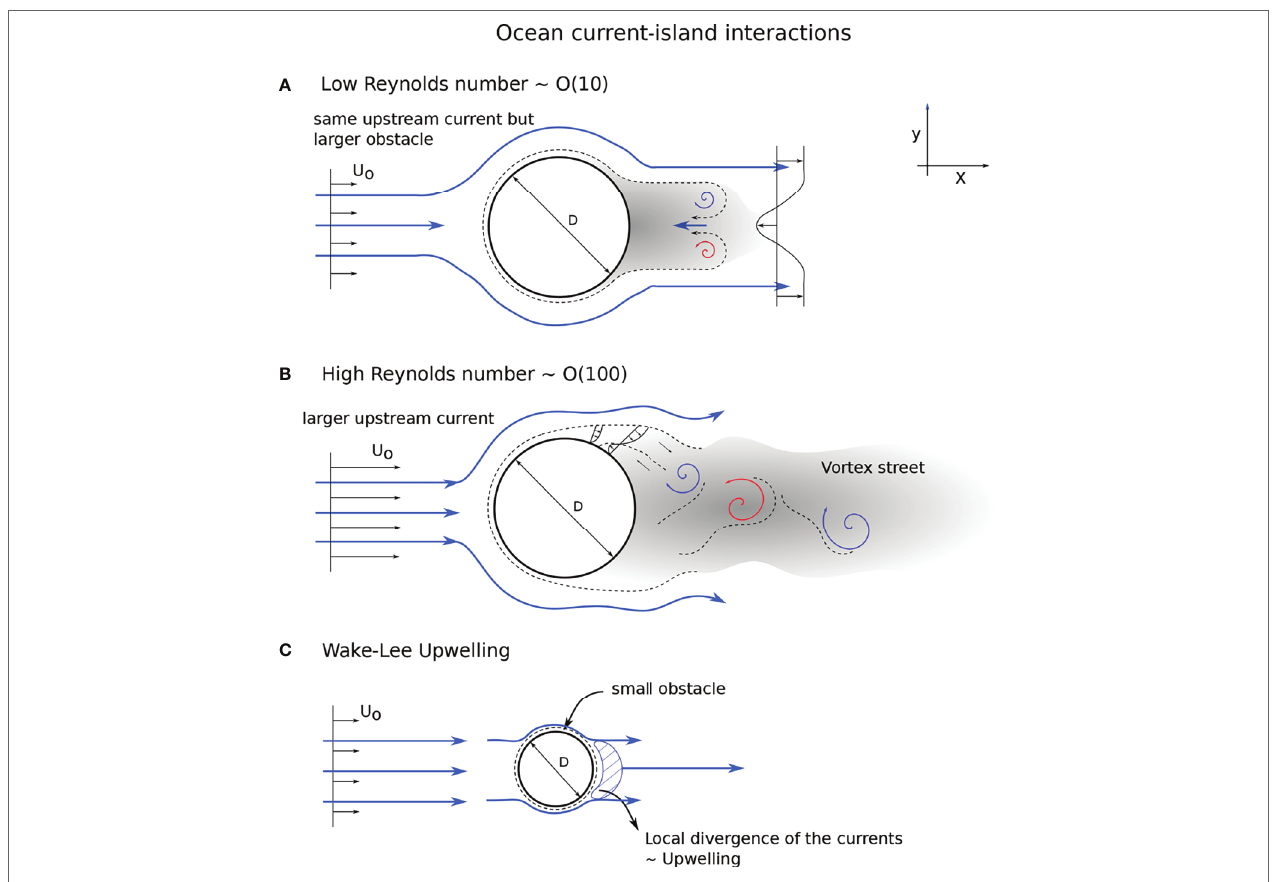
FIGURE 3 | Sketch of the ocean circulation in the wake of a circular island for Reynolds number of (A) O (10) , (B) O (100) and (C) wake-lee upwelling. Positive and negative vorticity in the ocean upper layer are represented with red and blue spirals, respectively. They lead to subsequent vertical velocities in the ocean. The upstream currents are uniform and represented by arrows U o on the left side of the obstacle of a diameter D . Blue arrows represent the streamlines of the